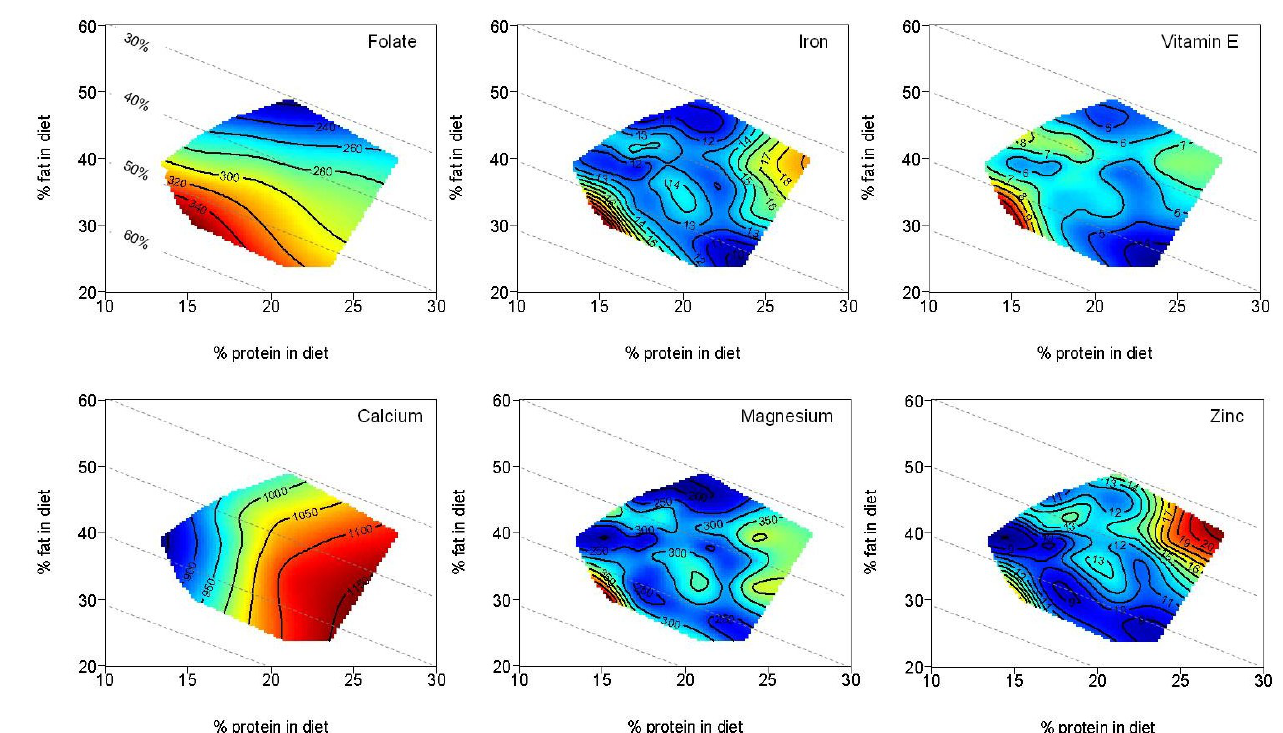
Figure 4. Effects of maternal macronutrient intakes during pregnancy on selected maternal micronutrient intakes. In these plots, known as right-angled mixture triangles [35], fat and protein (% of energy) increase along their respective axes in the normal way, and % carbohydrate decreases with distance from the origin. The negatively sloped dashed lines show the % carbohydrate, as labeled in the first graph. Plotted onto arrays of maternal dietary macronutrient composition points are fitted surfaces for the six response variables (folate, iron, vitamin E, calcium, magnesium and zinc). The isoclines for the micronutrient intakes rise in elevation from dark blue to dark red. Therefore, low micronutrient intakes are represented in the dark blue shading and increase to high micronutrient intakes in the red shading. Micronutrient intakes were generally optimized with a maternal diet of intermediate protein (18%E–20%E), intermediate fat (28%E–30%E) and intermediate carbohydrate (50%E–54%E) in comparison to Nutrient Reference Values ( n = 149). Folate and iron intakes were maximized with low protein (<16%E), intermediate fat (30%E) and high carbohydrate (>54%E) intakes. Nutrient Reference Values recommended for pregnancy: Folate = 520 μg, Iron = 22 mg, Vitamin E = 7 mg, Calcium = 840 mg, Magnesium = 290 mg, Zinc = 9 mg